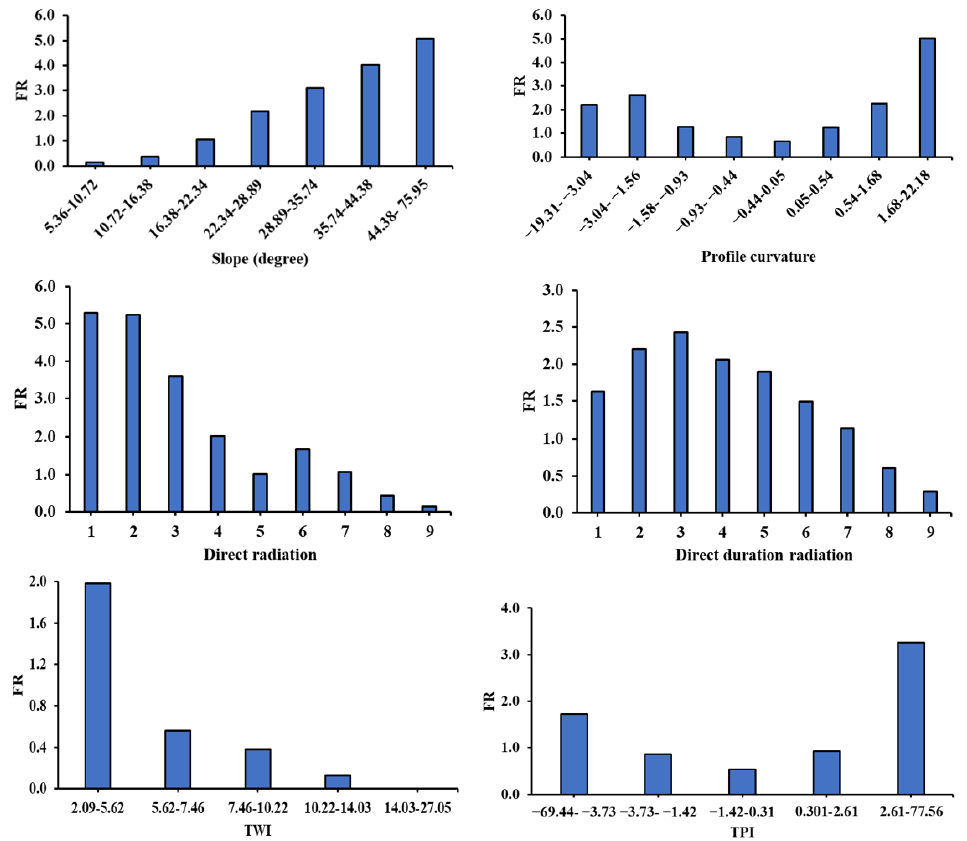
Figure 8. Frequency ratio plots of six important LIFs. Corresponding plots from the remaining LIFs are presented in Figure S2. Nomenclature of the classes of direct radiation and direct duration radi- ation is presented in Table